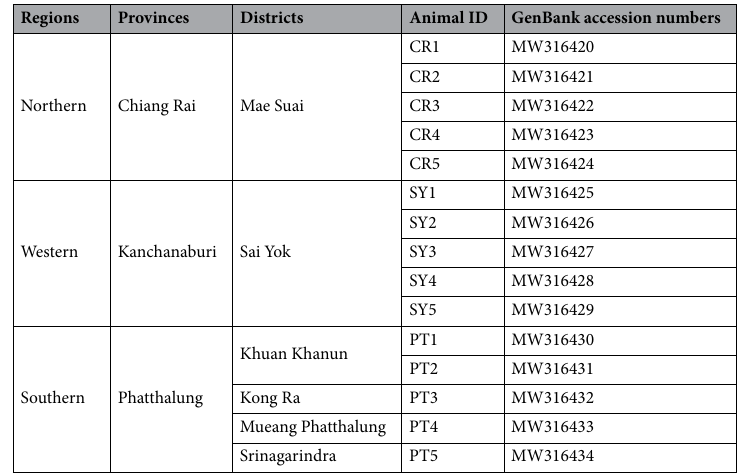
Table 6. The L. sabrazesi cytb nucleotide sequences amplified in Thailand strains were deposited in GenBank